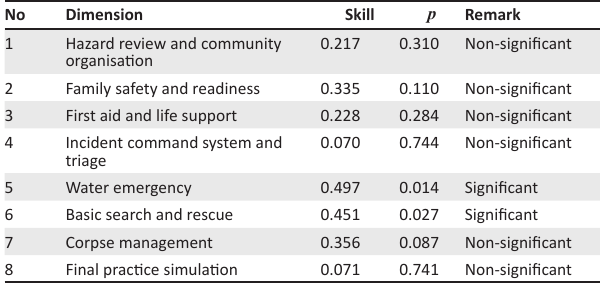
TABLE 1: Before and after test result scores in experiment group.